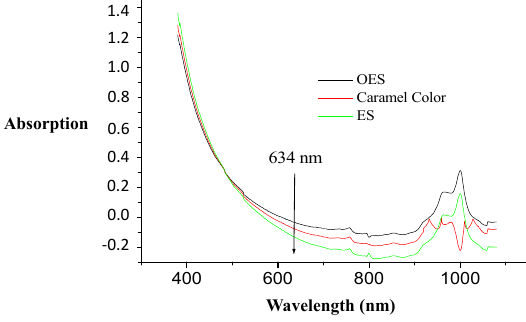
Figure 10. Optical scans of ES, oak ES (OES) and the caramel color.